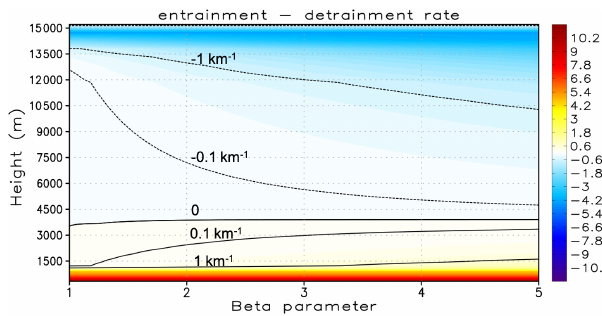
Figure 2. The universe of solutions for the effective net mass ex- change rate (entrainment – detrainment, km − 1 ) for the case shown in Fig. 1. The black contour lines demark the transition from mostly entraining to mostly detraining